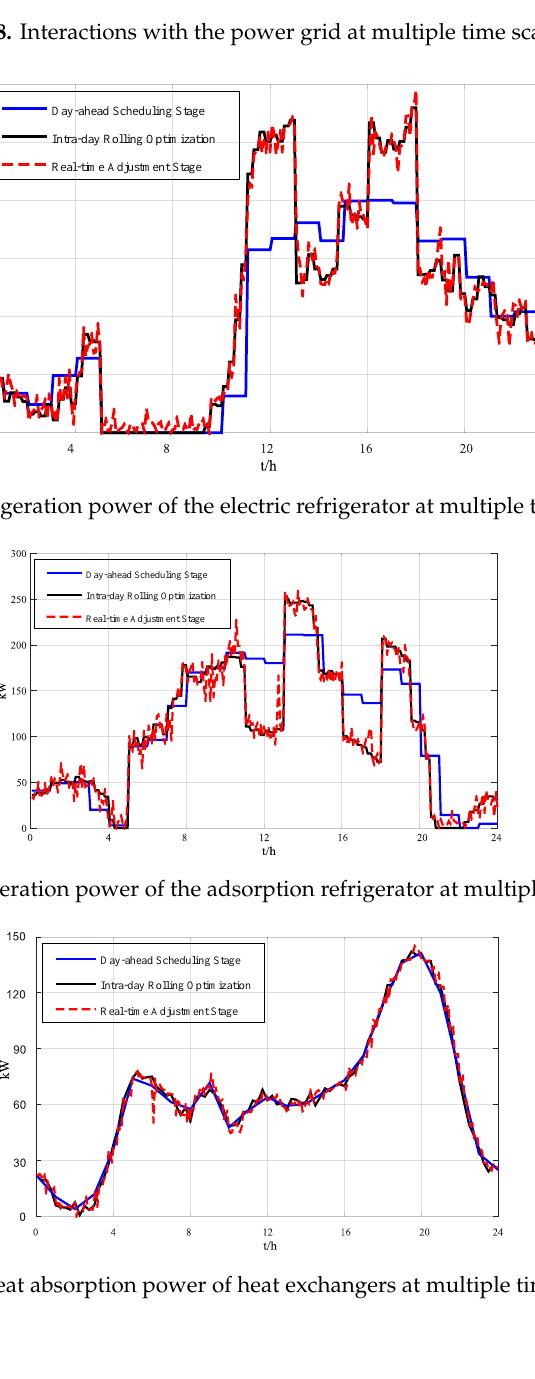
Figure 8. Interactions with the power grid at multiple time scales. Processes 2020 , 10 , x FOR PEER REVIEW